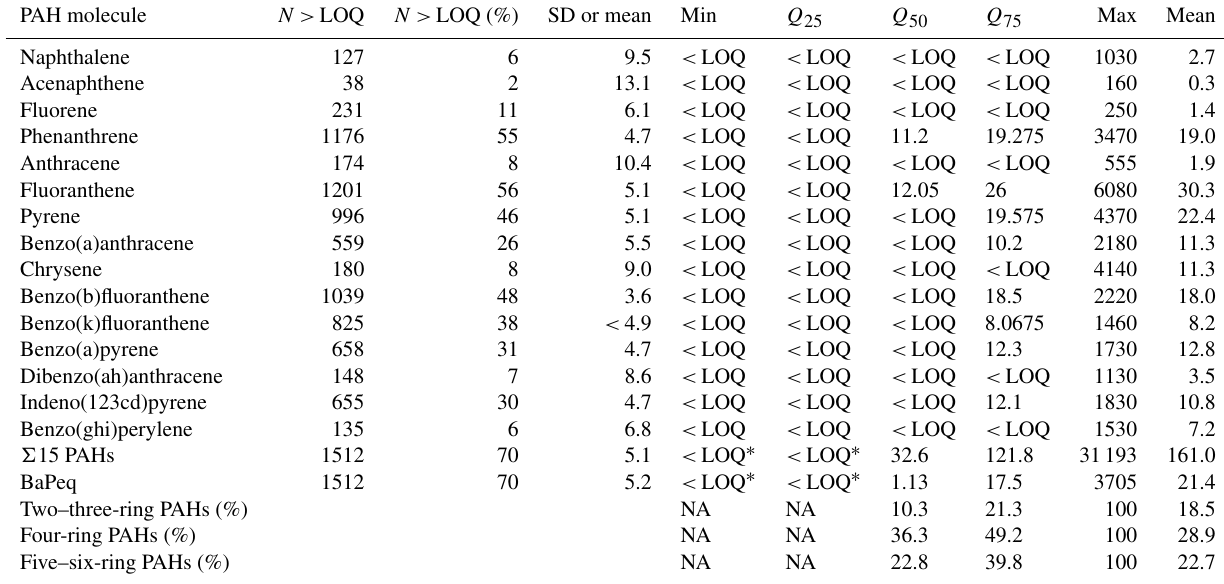
Table 3. Summary of descriptive statistics in micrograms per